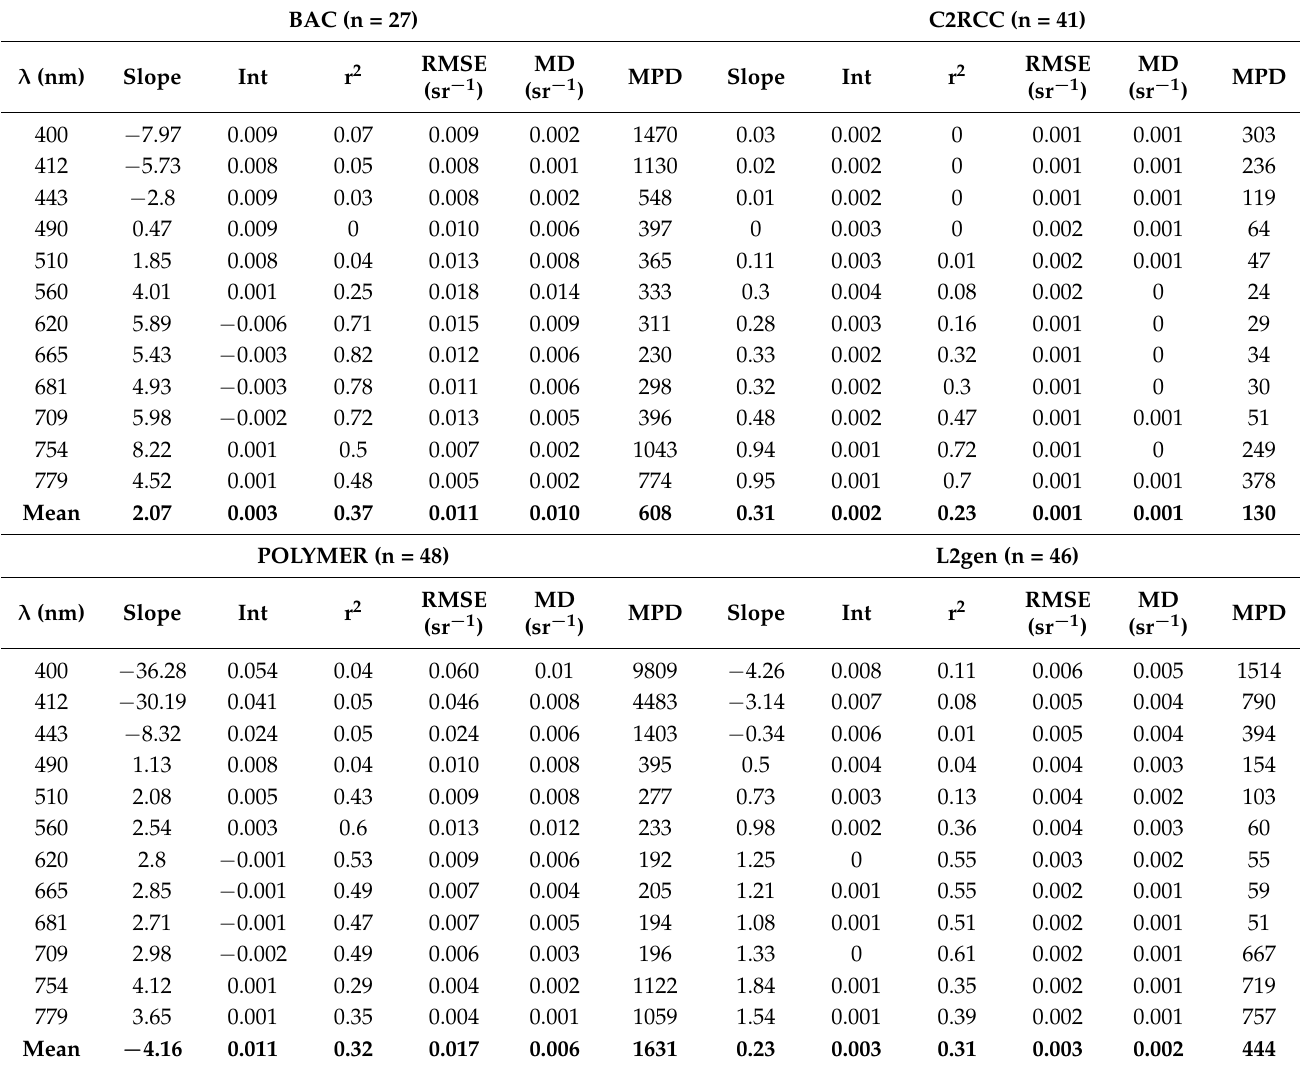
Table 1. Statistical matchup results for satellite-derived R rs processed by each atmospheric correction algorithm against in situ R rs